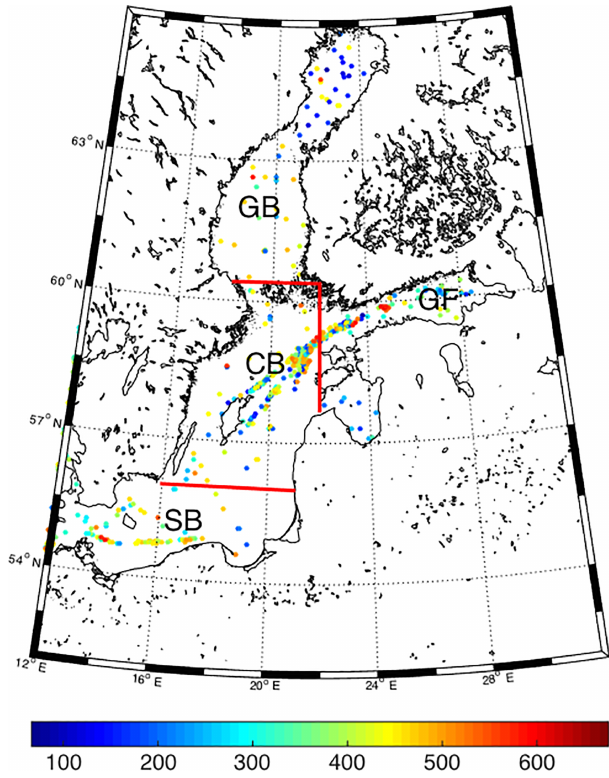
Figure 1. Data available for the Baltic Sea for 1998–2011. The dashed red lines indicate the division into the Central Basin (CB), Gulf of Finland (GF), Gulf of Bothnia (GB), and South Basin (SB). The colour bar shows the p CO 2 values